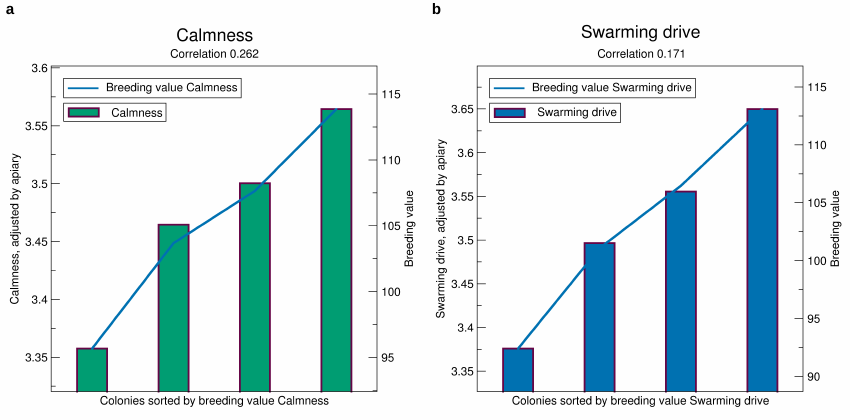
Figure 6. Comparison of prospective breeding values of queens tested in a year, iterated from 2014 to 2019, to the phenotypes standardized to an average apiary, see Section 2.3. ( a ) Calmness. ( b ) Swarming drive. Significances of all correlations are p < 10 − 16 . The standard errors are about 0.4 for calmness and 0.6 for